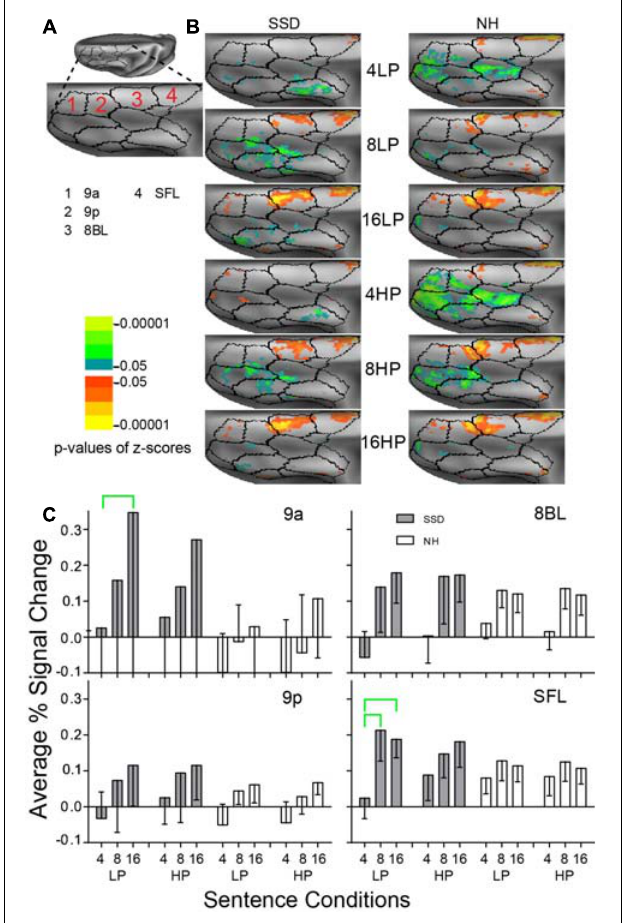
FIGURE 8 | Results from four parcels in the LH Dorsolateral Prefrontal Cortex (DLPFC) region. (A) A dorsal view of a partially inflated hemisphere shows the DLPFC region. (B) Enlarged views of parcels show clusters with significant mean z-scores of p < 0.05 for positive BOLD (colored red-orange to bright yellow) and negative BOLD scaled blue to light green. (C) 9a and SFL had significant intelligibility effects marked with green brackets.